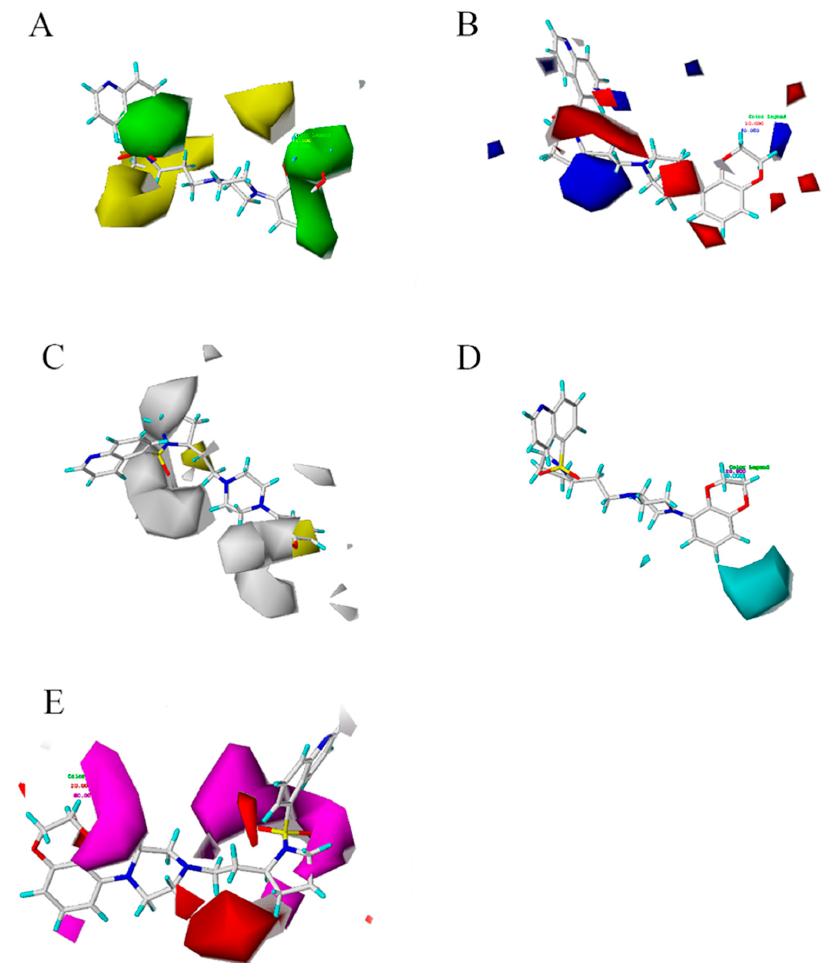
Figure 3. Contour maps of CoMSIA model based on 43rd structure. ( A ) is the steric field diagram, favorable (green) and unfavorable (yellow). ( B ) is the electrostatic field diagram, positive (blue) and negative (red) areas. ( C ) is the hydrophobic profile diagram, favorable (yellow) and unfavorable (white). ( D ) is the hydrogen donors diagram, favorable (cyan). ( E ) is the hydrogen acceptor diagram, favorable (magenta) and adverse (red) hydrogen receptor areas.